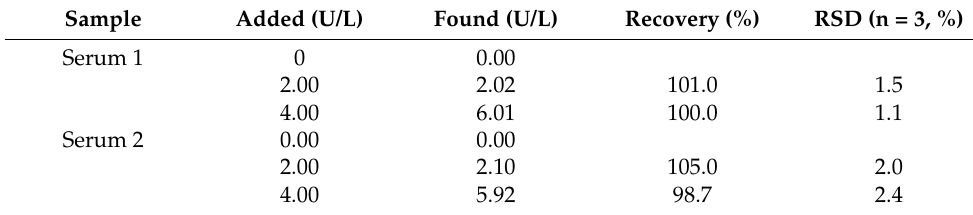
Table 2. Determination of urease in human serum Table 1. Determination of urea in human urine samples.